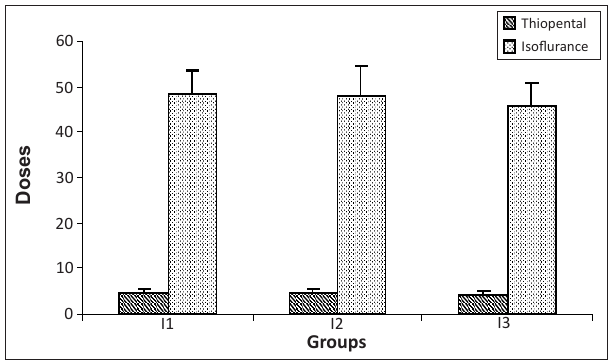
FIGURE 4: Mean ± standard error of doses of thiopental sodium (mg/kg) and isoflurane (mL) in water buffaloes of different groups.